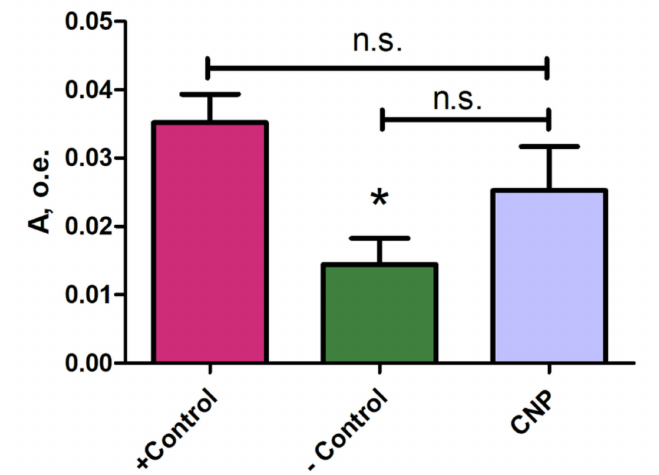
Figure 2. Absorbance (A) of rat plasma 60 min after intravenous administration of the suspension of chitosan nanoparticles ( n = 7). + Control—positive control – artificially hemolyzed 5 ± 2% red blood cell suspension ( n = 5); –Control—negative control (saline, n = 5). Mean ± SEM. * – p < 0.05 with respect to + Control. n.s.—nonsignificant. Increased plasma-free hemoglobin level is a sign of hemolysis. If intravenously administrated CNPs cause in vivo hemagglutination and hemolysis, then free hemoglobin should appear in the blood plasma samples, which is determined by the absorption values at a wavelength of 540